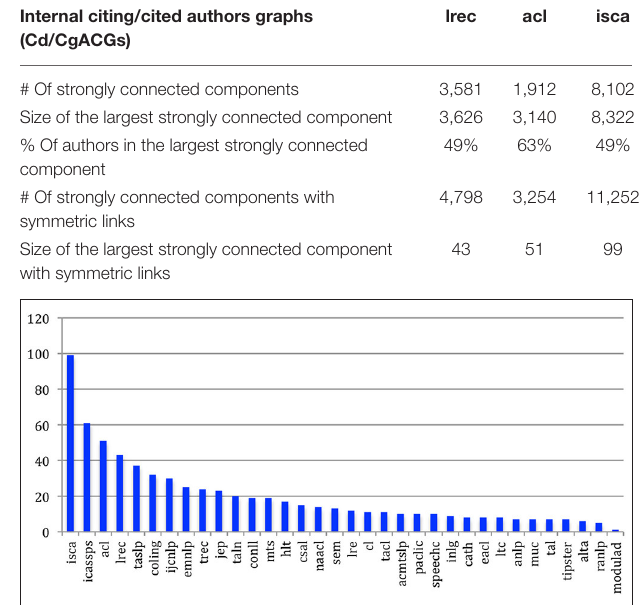
FIGURE 46 | Density of the internal authors citation graph.